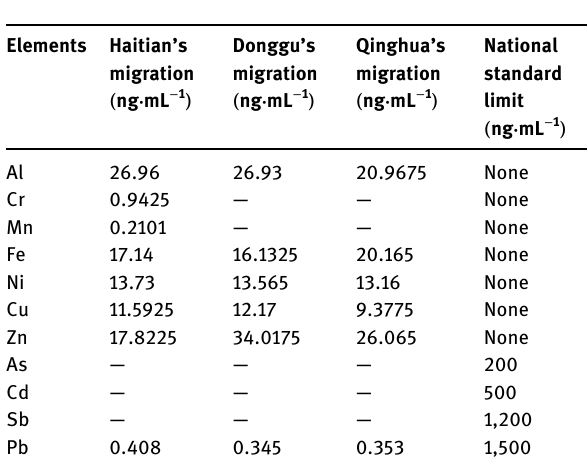
Table 4: Trace elements migration in di ff erent brands of soy sauce